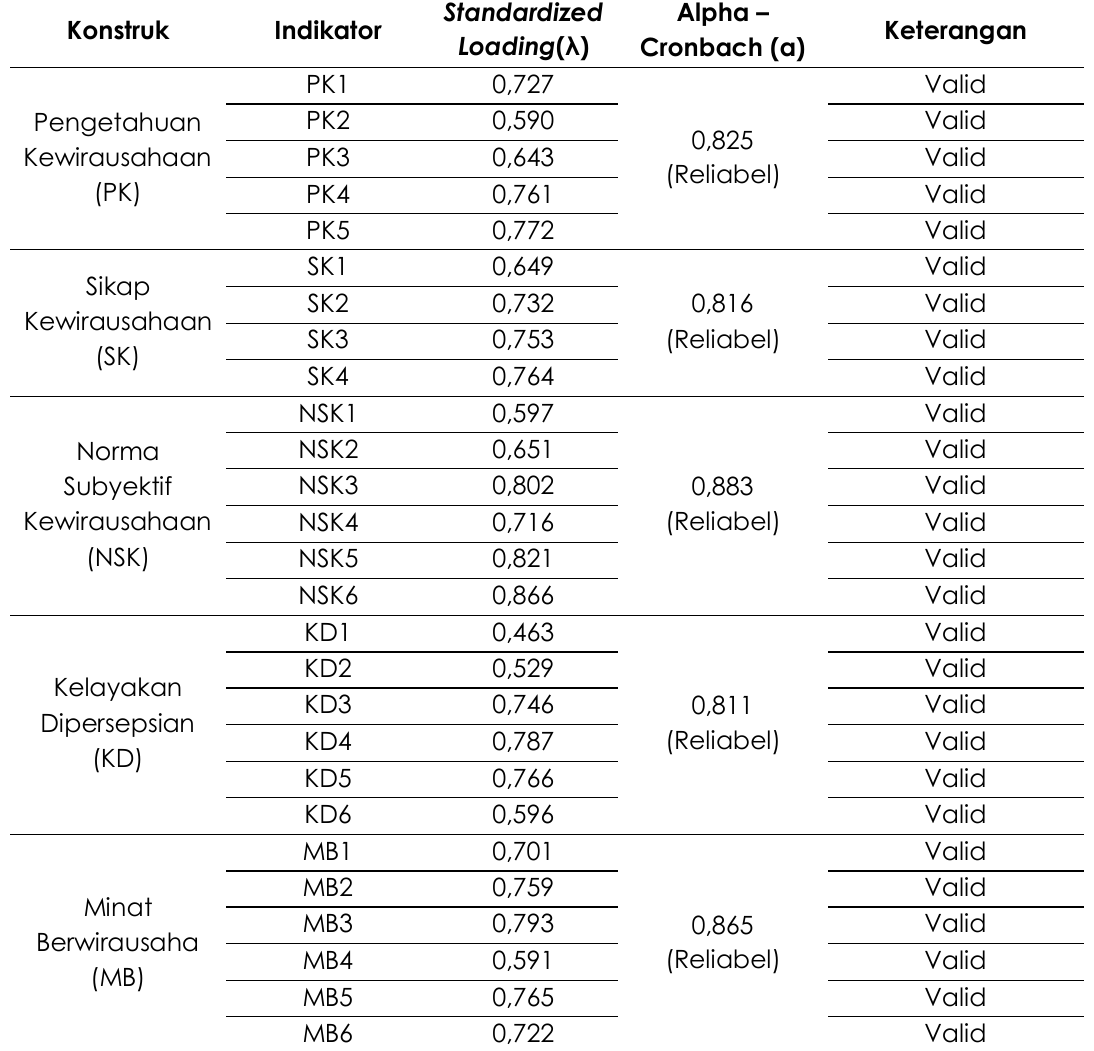
Tabel 1. Hasil uji validitas dan